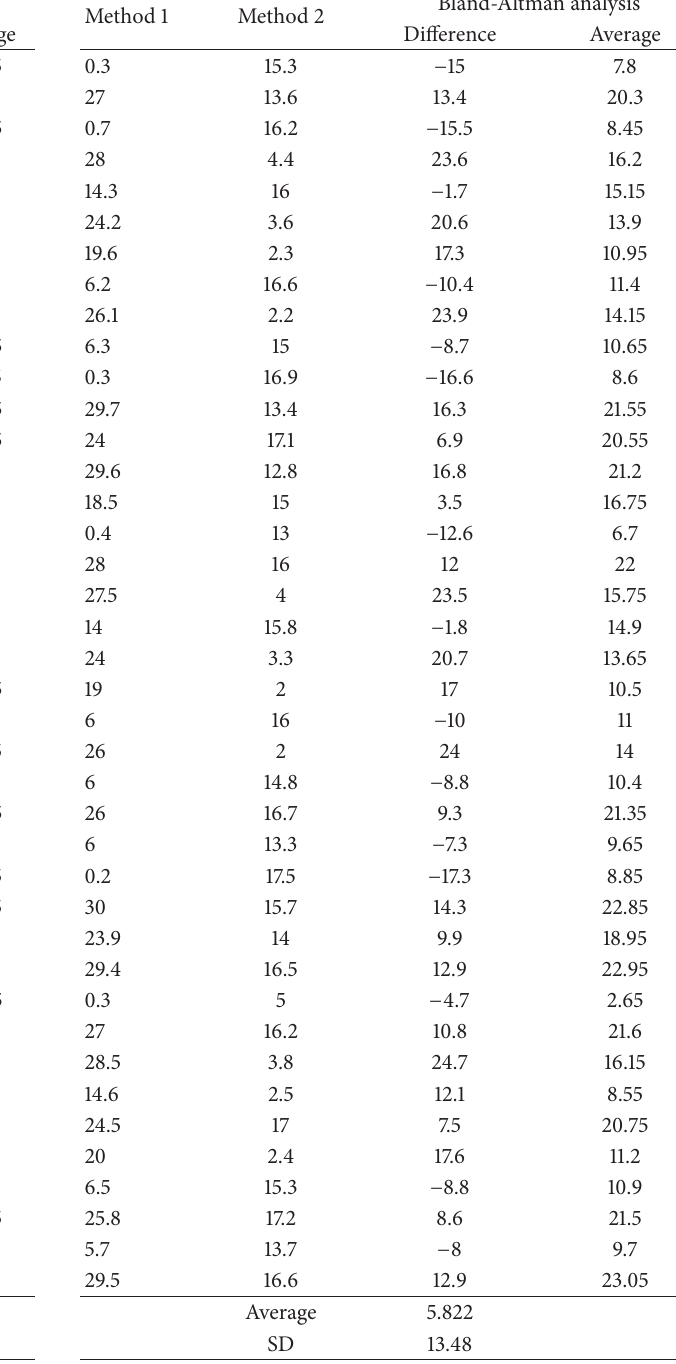
Table 6: Quarter S-N/I-T Bland-Altman analysis (see Figure